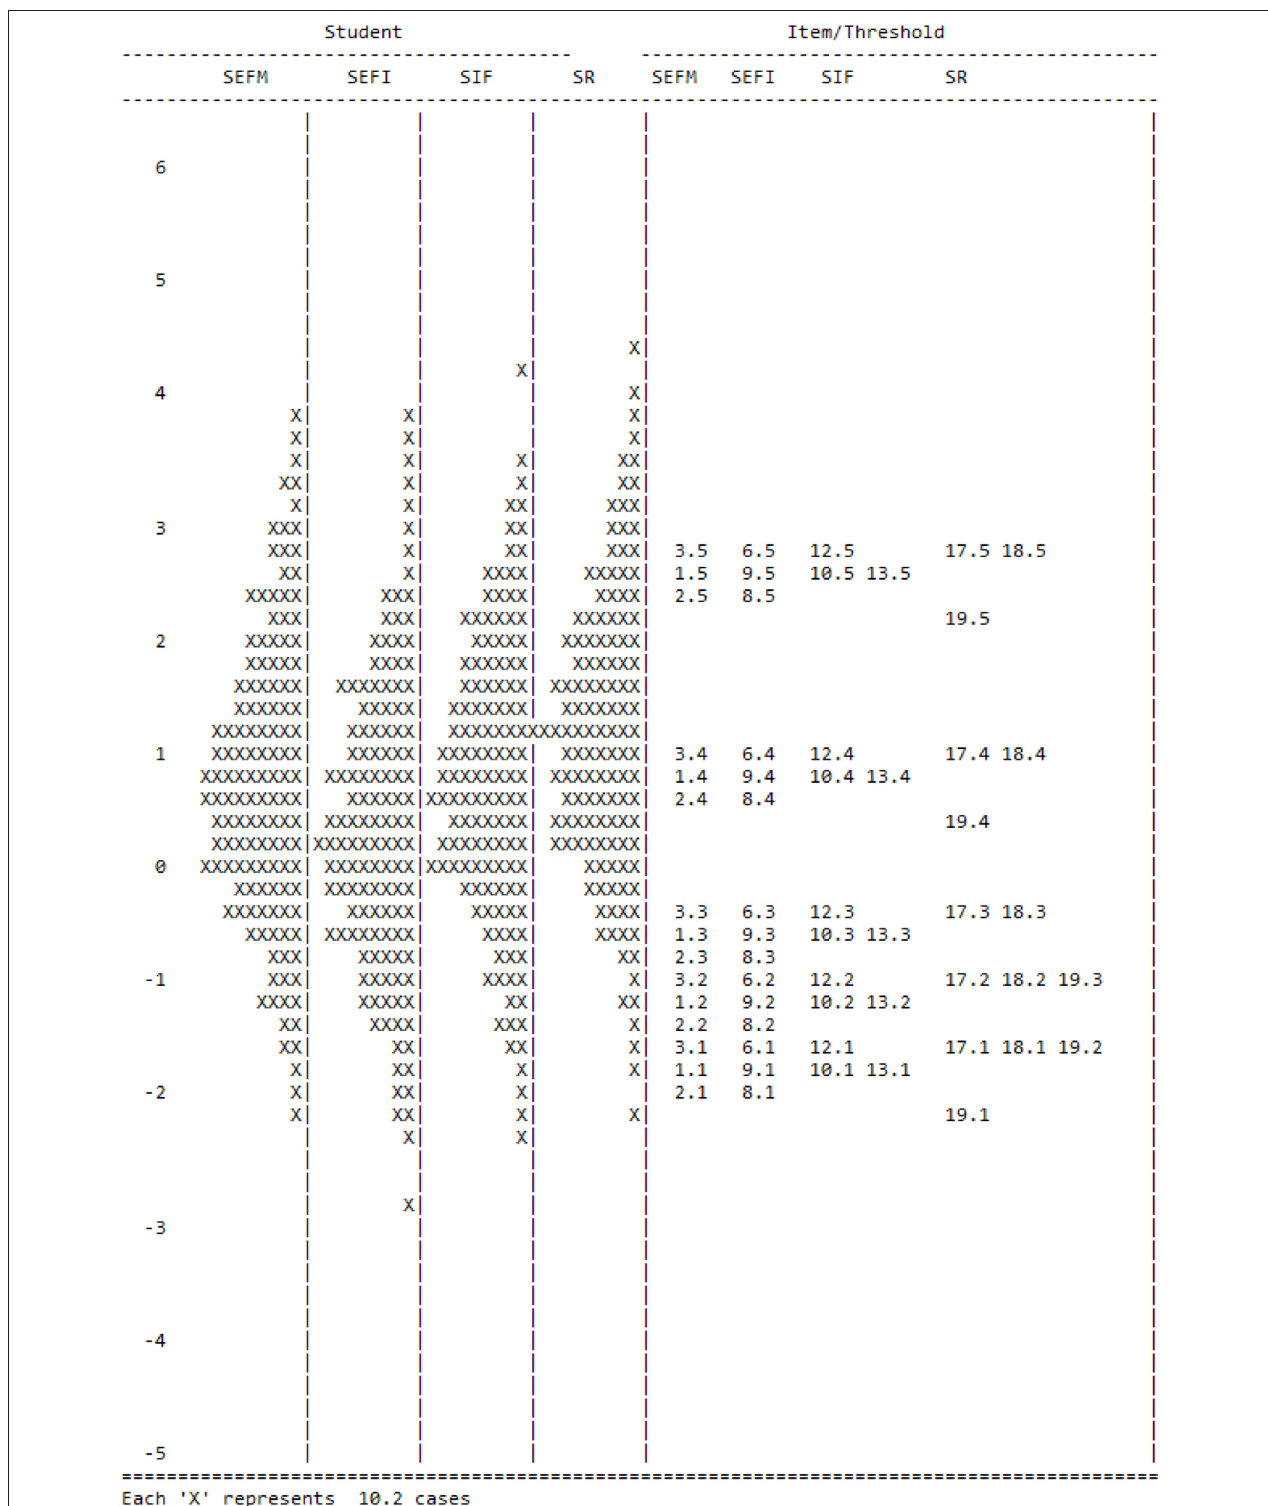
FIGURE 4 | The Wright map of the